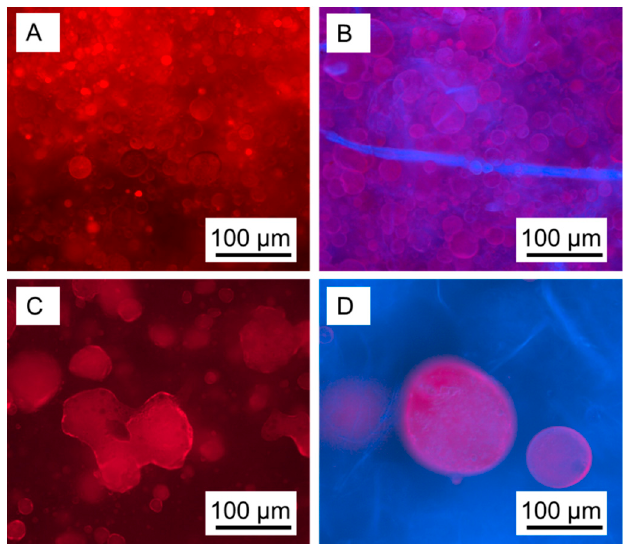
Figure 4. Visible-light ( A , C ) and fluorescence ( B , D ) microscopy of unsaturated polyester resin in water emulsions stabilised by MFLC ( A , B ) and MFC ( C , D ). Red colour corresponds to unsaturated polyester and blue colour corresponds to celluloses.